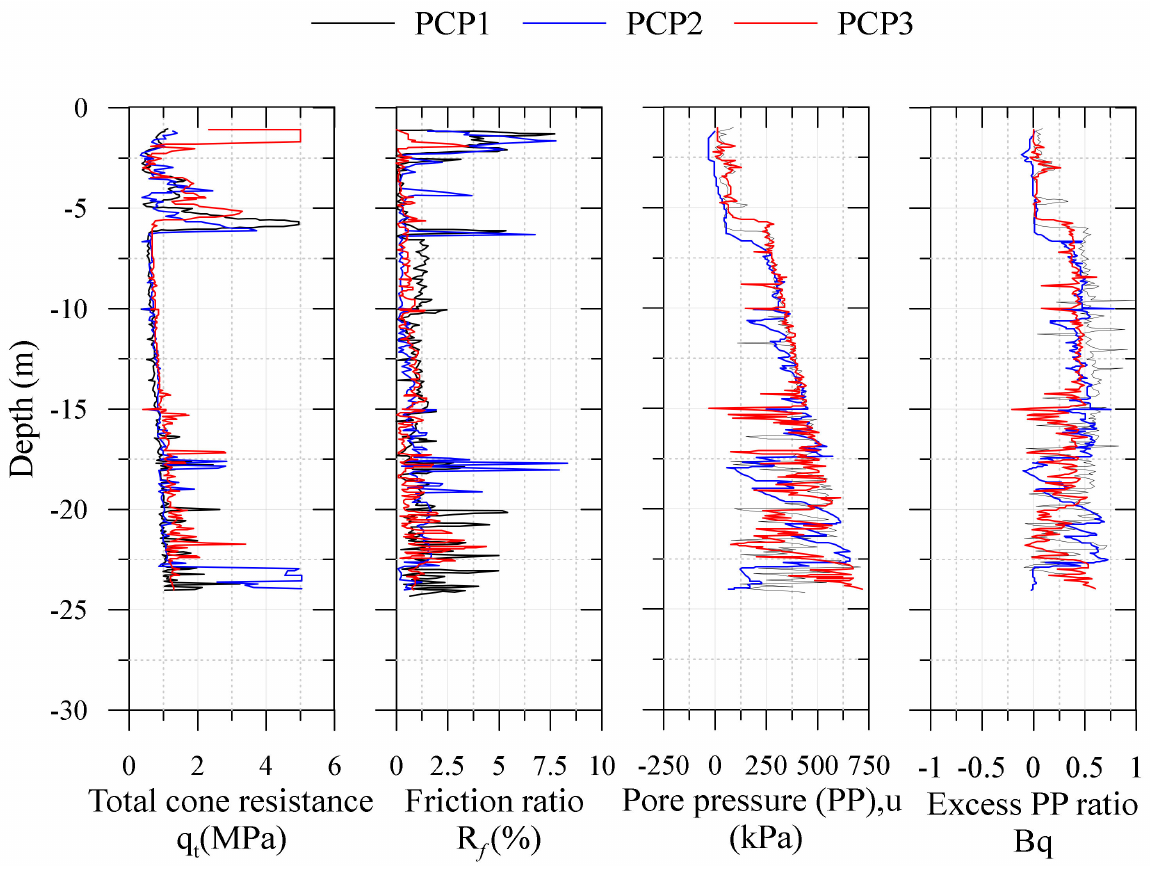
Figure 3. Cone penetration test data of the Nerang Broadbeach Roadway embankment at chainage 400–500. From boreholes and CPT data, it was observed that in the Reduced Level (RL) 1.19 m to − 2.00 m, the soil deposit was dark grey, lightly moist, loose silty sand. In this layer, the organic root fragments were also noticed. Then, at RL = − 2.00 m to − 5.90 m, the soil was grey, wet, very loose to loose sand. From the vane shear test report, a similar soil type was found at this depth. Robertson and Cabal [23] and Mayne [24] reported that during the CPT test in sandy layers, negative pore pressure developed due to the dilation of granular materials. Identical negative pore pressure responses were observed in CPT data at RL = − 3.50 m (see Figure 3). At RL = − 5.90 m to − 7.00 m, soft grey moist clay